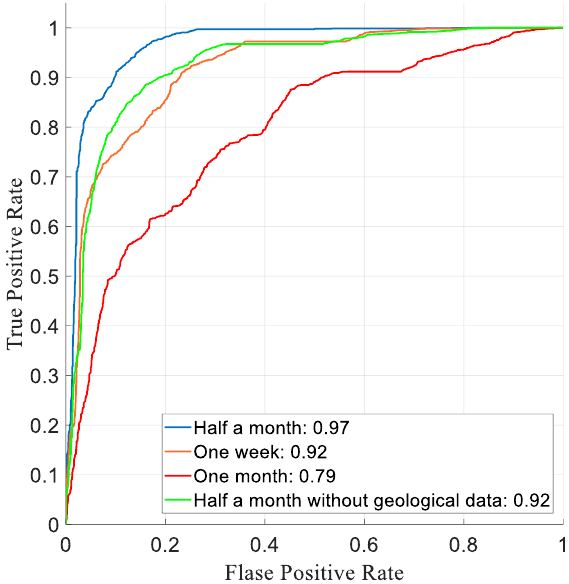
Figure 8. ROC curve of classification models on test sets.